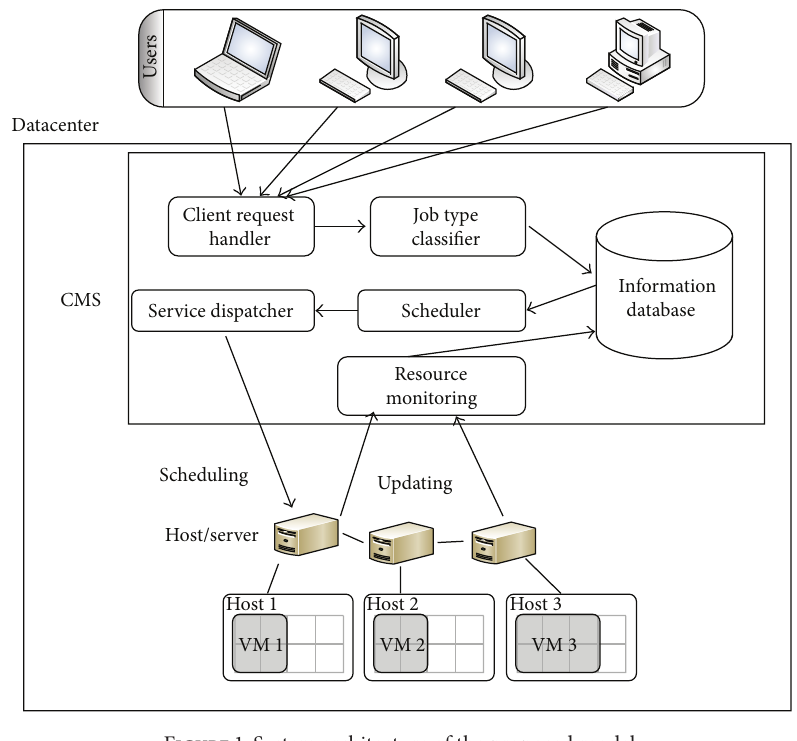
Figure 1: System architecture of the proposed model.